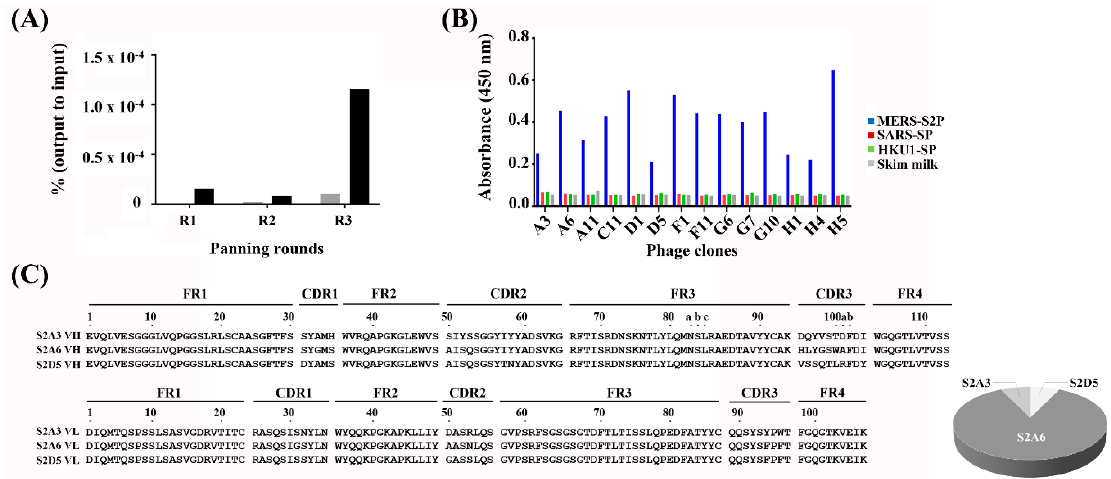
Figure 1. Output of the panning of the phage-displayed synthetic Fab library on MERS-S2P. ( A ) Monitoring of phage titers over three rounds (R1–R3) of panning. Black and gray bars indicate a ratio of phage output to input titers presented as a percentage (%) from panning on MERS-S2P-immobilized and -non-immobilized surfaces, respectively. The ratio of output to input (%) = (phage output titer ÷ phage input titer) × 100. ( B ) Phage ELISAs performed on MERS-S2P-, SARS-CoV spike protein-, a CoV spike protein-immobilized surfaces (blue, red, and green, respectively). ( C ) Amino acid sequences of three unique clones identified from panning (left) and their relative frequencies (%) (right). The sequences were aligned using the Kabat numbering system [38]. ELISA, enzyme-linked immunosorbent assay; MERS-S2P, Middle East respiratory syndrome-CoV S2 subunit protein; SARS-SP, severe acute respiratory syndrome-CoV S protein; HKU1-SP, hCoV HKU1 S protein; CoV, coronavirus; CDR, complementarity-determining region; FR, framework region.